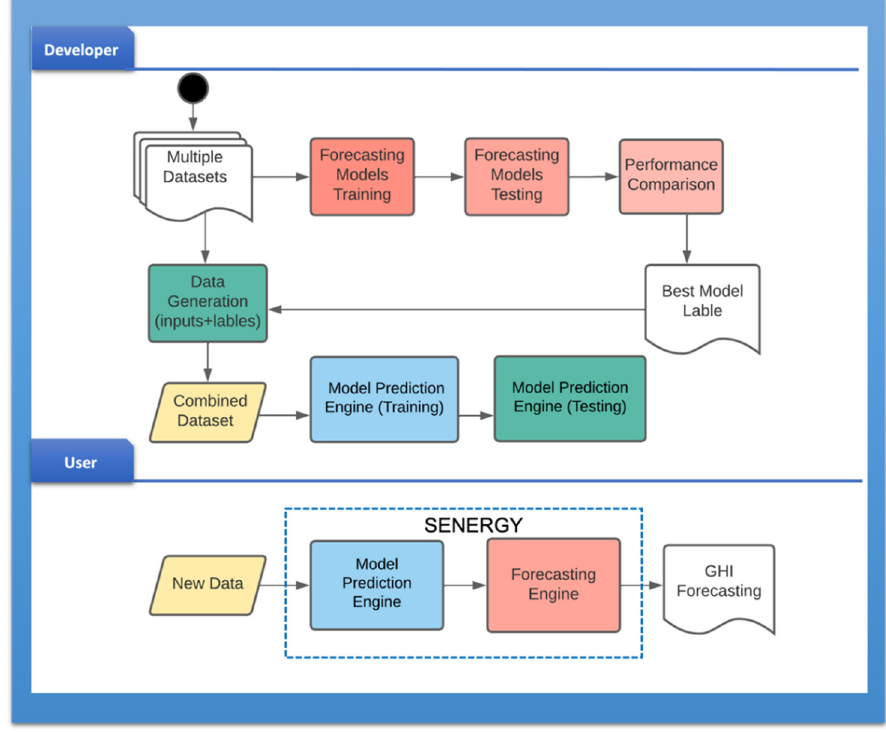
Figure 4. SENERGY development process.